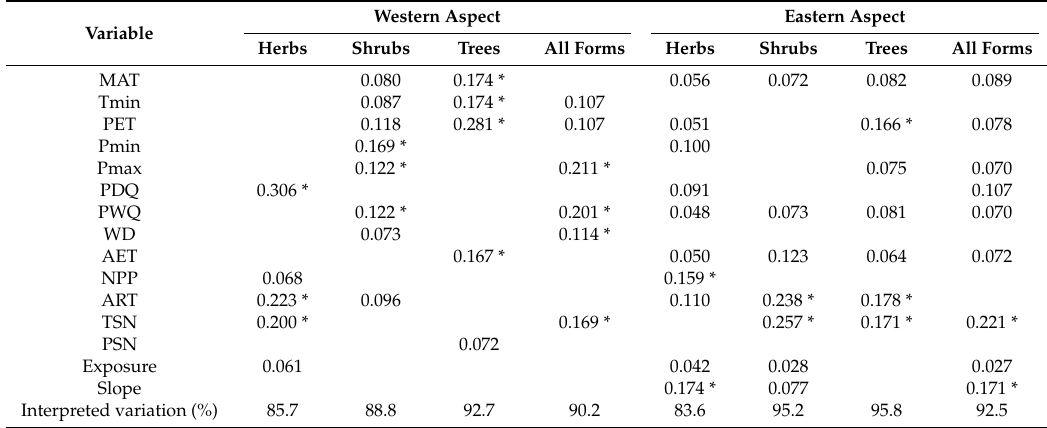
Table 3. Hierarchical variation partitioning of elevation-related species richness patterns of herb, shrub and tree species and of all species on the western and the eastern aspects of Baima Snow Mountain. Refer to Table 2 for abbreviation and definitions. Western Aspect Eastern Variable